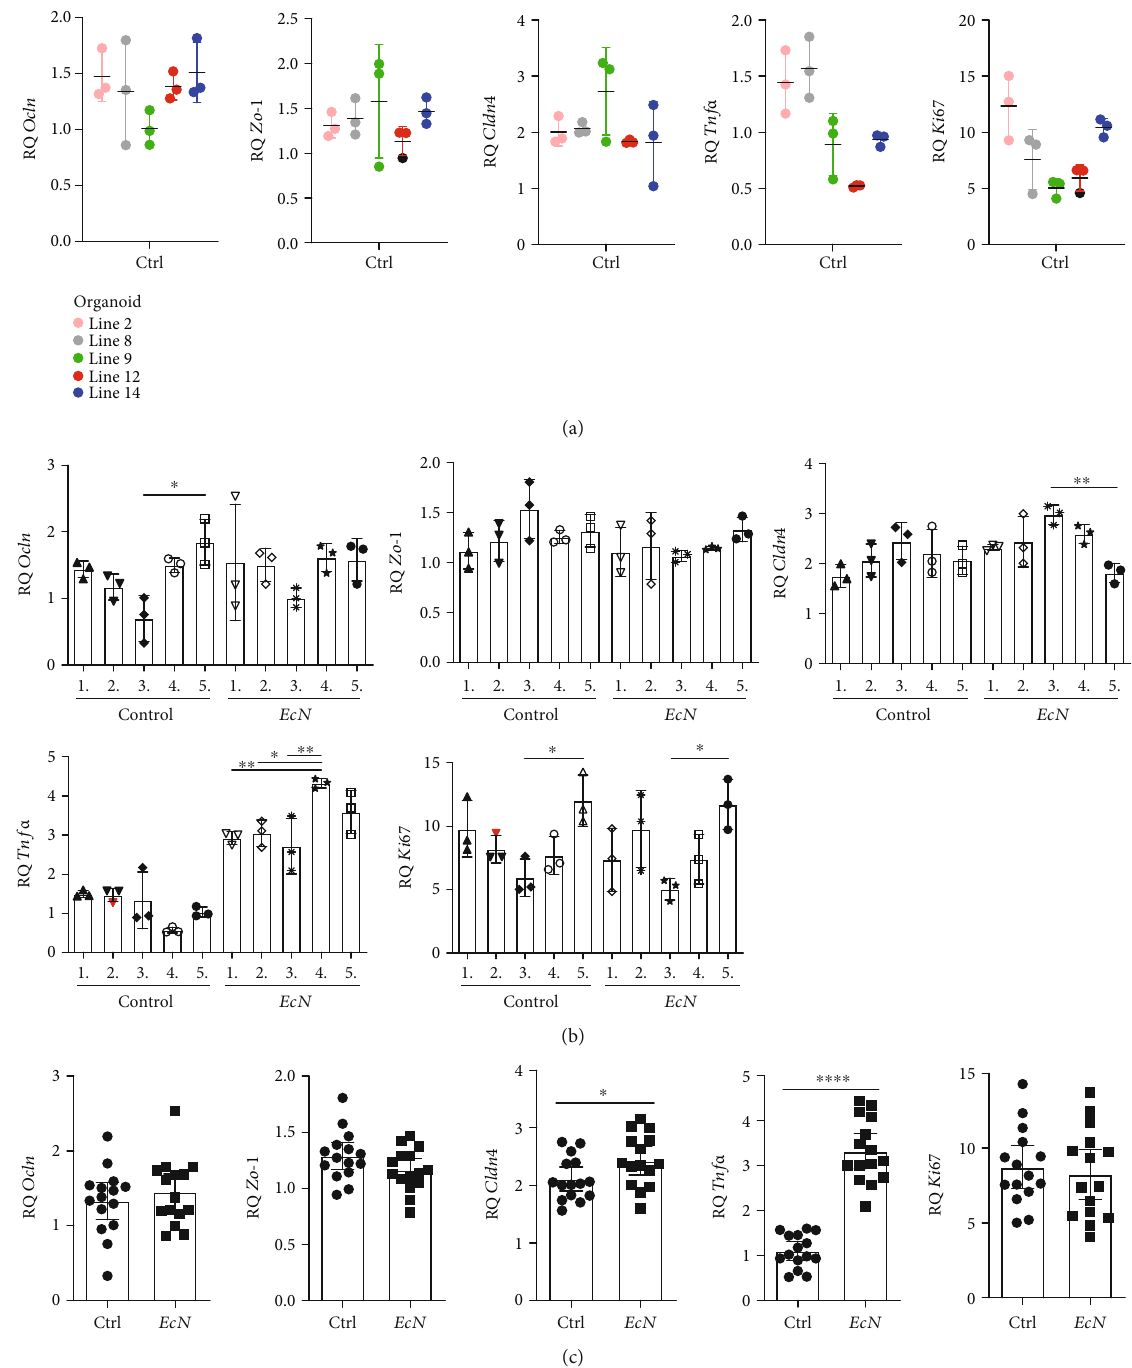
Figure 2: Experimental data are predominantly a ff ected by interexperimental di ff erences. The technical and experimental reproducibility and the biological variability in colonoids were compared using the EcN infection model. ∗ P < 0 : 05 , ∗∗ P < 0 : 01 , ∗∗∗ P < 0 : 001 , and ∗∗∗∗ P < 0 : 0001 . (a) Technical replicates. The graphs plot individual values of fi ve representative organoid lines with the technical replicate mean and SD values; the outliers, as identi fi ed using the Grubbs outlier test, are shown as black dots. (b) Experimental and biological replicates. The graphs plot fi ve independent experiments with the technical replicate means from three di ff erent organoid lines (biological replicates) per experiment plus the overall mean and SD per experiment; the outliers, as identi fi ed using the Grubbs outlier test, are shown as red triangles; ANOVA: Ocln ( F ð 9, 20 Þ = 2 : 609 , P = 0 : 0355 ), Zo-1 ( F ð 9, 20 Þ = 1 : 538 , P = 0 : 2019 ), Cldn4 ( F ð 9, 20 Þ = 4 : 227 , P = 0 : 0035 ), Tnf α ( F ð 9, 20 Þ = 29 : 69 , P < 0 : 0001 ), and Ki67 ( F ð 9, 20 Þ = 4 : 150 , P = 0 : 0039 ). (c) Pooled data. The graphs plot the technical replicate means of all biological replicates ( n = 15 ) from all independent experiments plus the overall mean and 95%